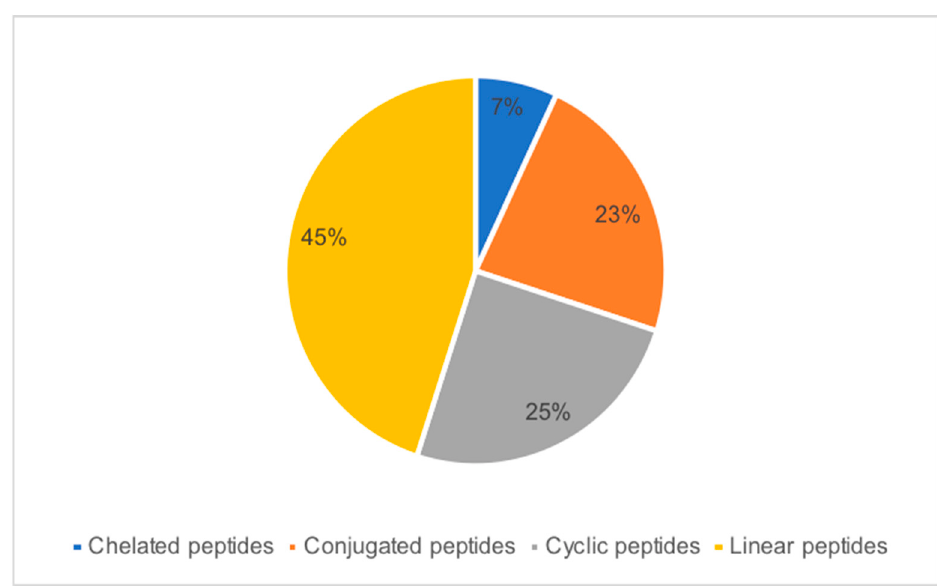
Figure 6. Different categories of peptide-based drugs.